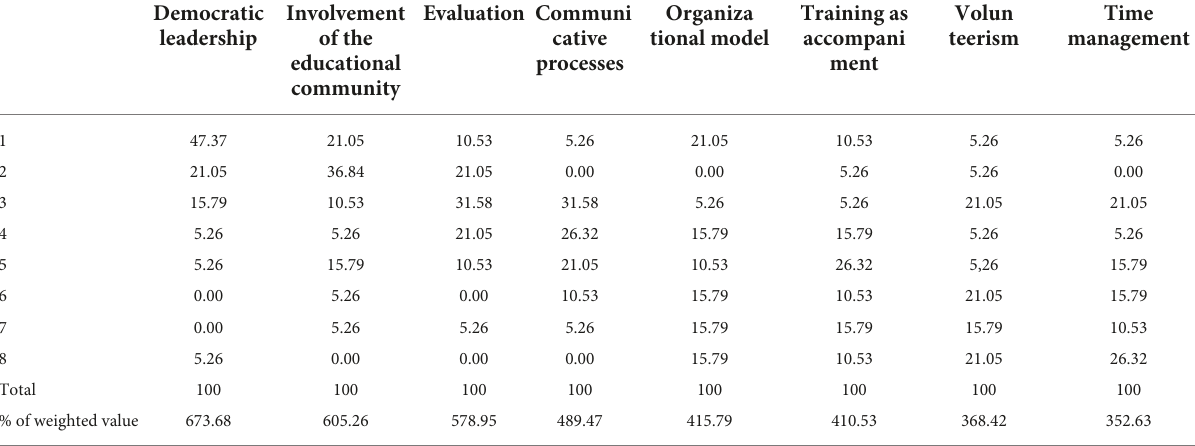
TABLE 8 Opinions on the relationship between innovation and organization of the center, from highest to lowest